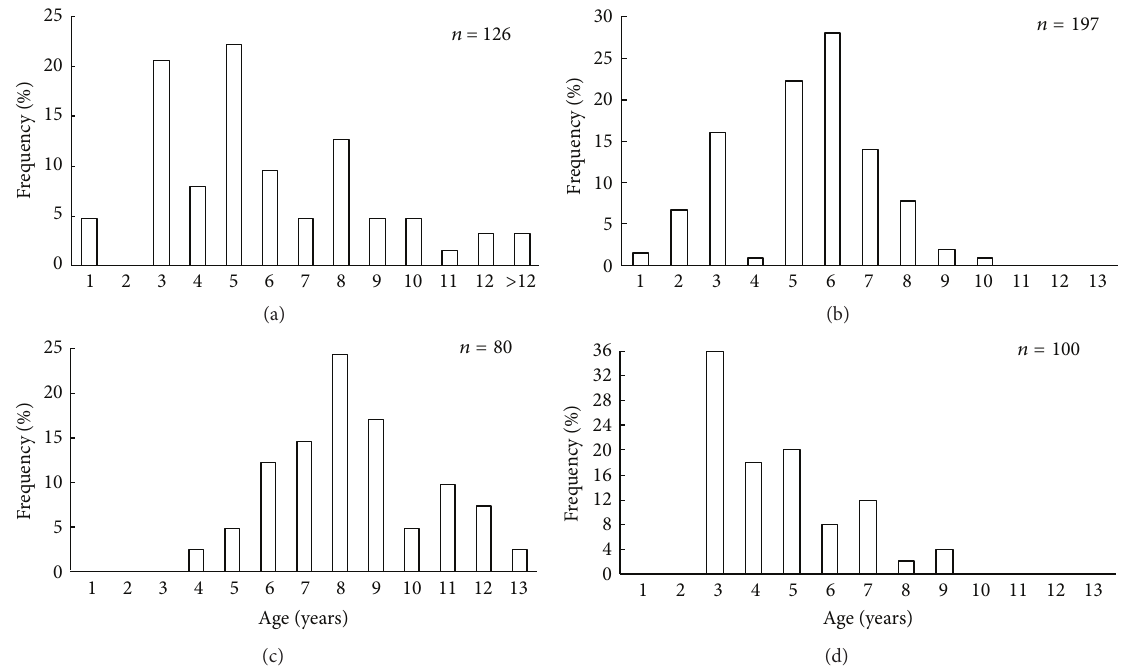
Figure 2: Patinopecten yessoensis. Age structures of the scallop populations from (a) Melkovodnaya Bay, (b) Ozero Vtoroe Bay, (c) Vityaz Bay, and (d) Zapadnaya Bay of Furugalm Island. n is sample